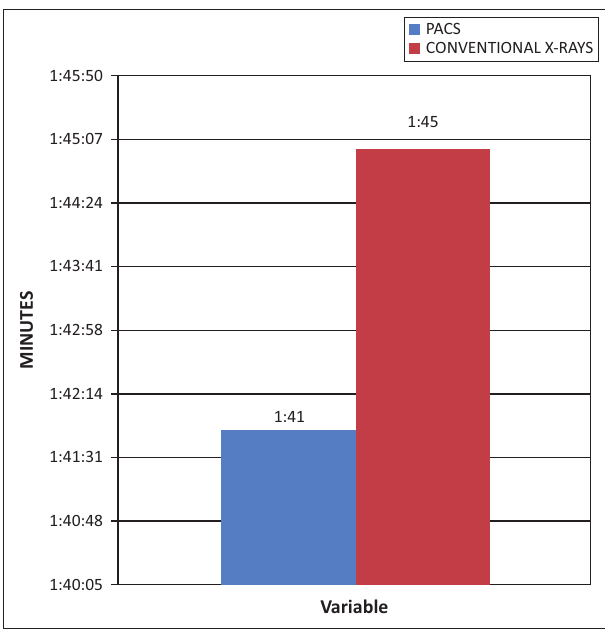
FIGURE 3: Patient waiting times in minutes for MRI brain scans at Hospital A (PACS) ( N = 52) and Hospital B (conventional) ( N =